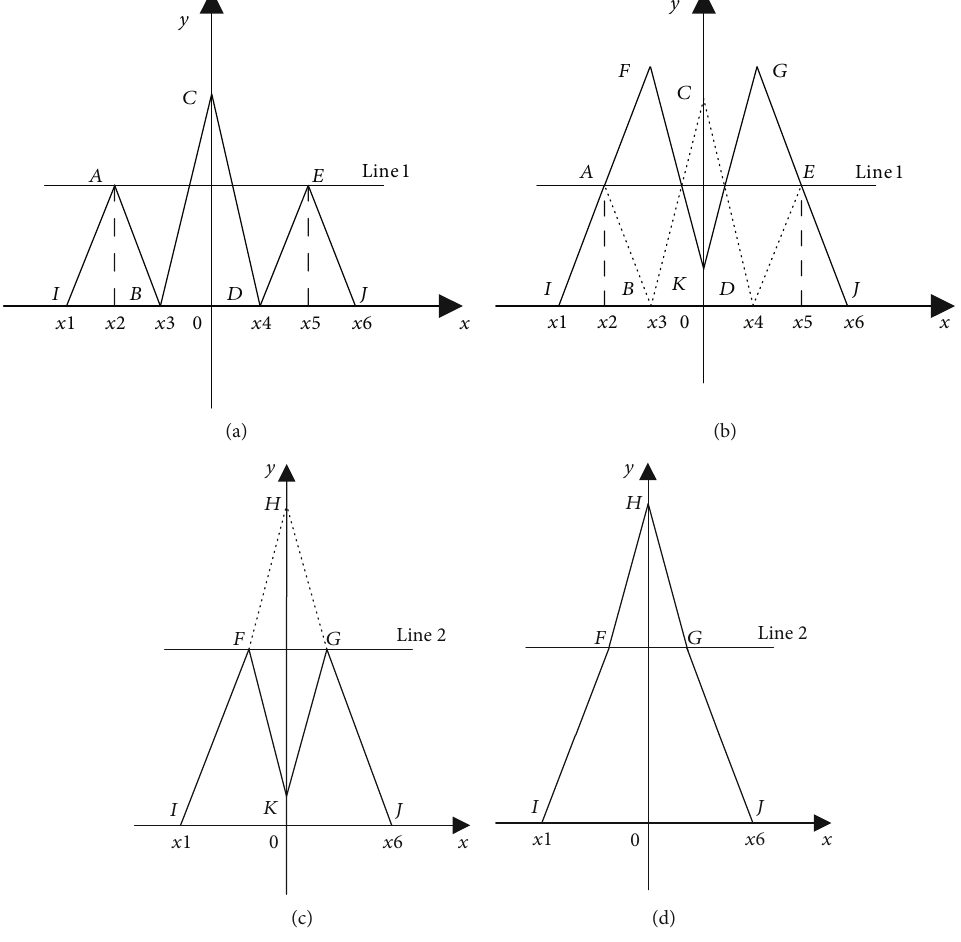
Figure 4: Principle of